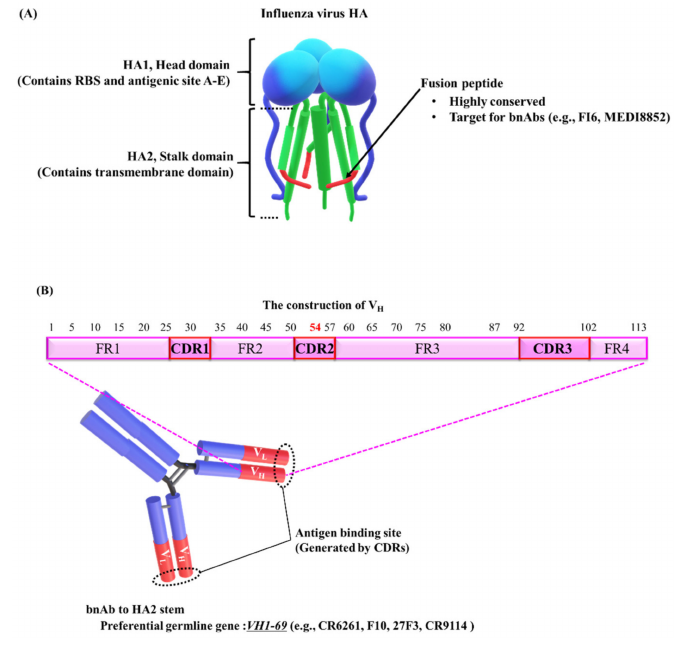
Figure 1. Schematic diagram of HA, the target for broadly neutralizing antibodies (bnAbs). ( A ) The model shows hemagglutinin (HA) structure (prefusion). HA is composed of a globular head domain (HA1) and a stalk domain (HA2) with a highly conserved sequence, the fusion peptide. The HA structure model was obtained from [81–84]. ( B ) The VH1-69 germline gene generally dominates the human bnAb response to the HA2 stalk domain. The variable domain of heavy chains (V H ) consists of four framework regions (FR1-4) and three complementary determining regions (CDR1-3). The phenylalanine at position 54 (F54) is conserved in VH1-69 and is required for initial development of most VH1-69 antibodies. However, in the process of a ffi nity maturation, F54 and accumulated mutations are functionally redundant. The numbers indicate the residue positions